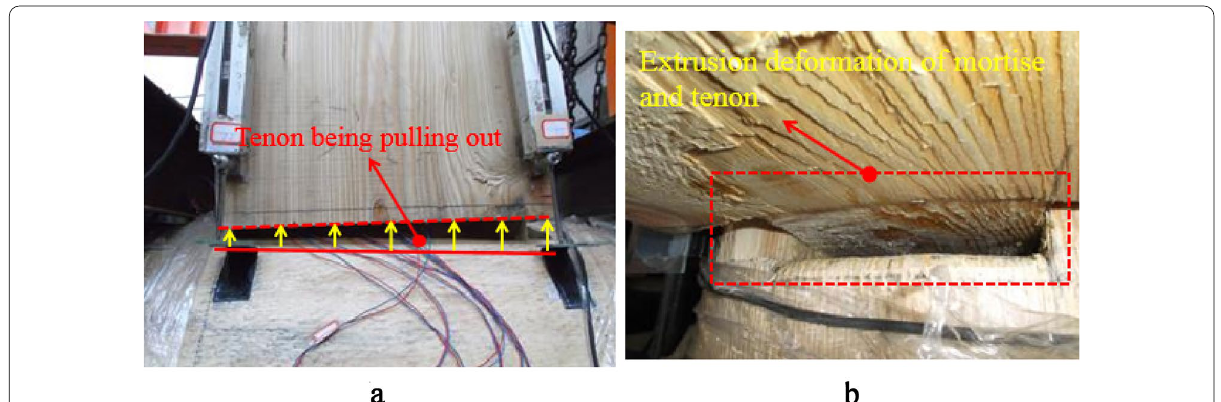
-30-25-20-15-10-5051015202530 -0.16 -0.12 -0.08 -0.04 0.00 0.04 0.08 0.12 0.16